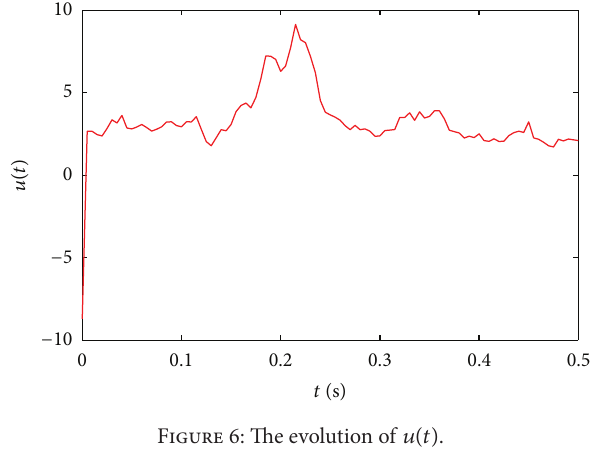
Figure 6: The evolution of 𝑢(𝑡)